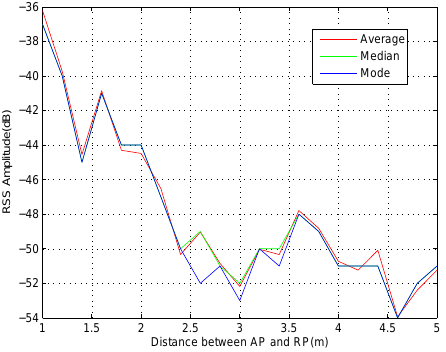
Figure 4. RSS Amplitude values at 21 different locations, which have a distance from 1 to 5 m between AP and RP.